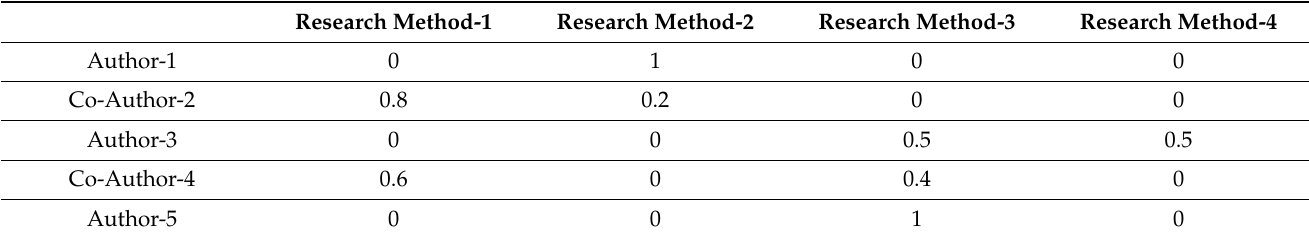
Table 1. Example of author–research method probability distribution.